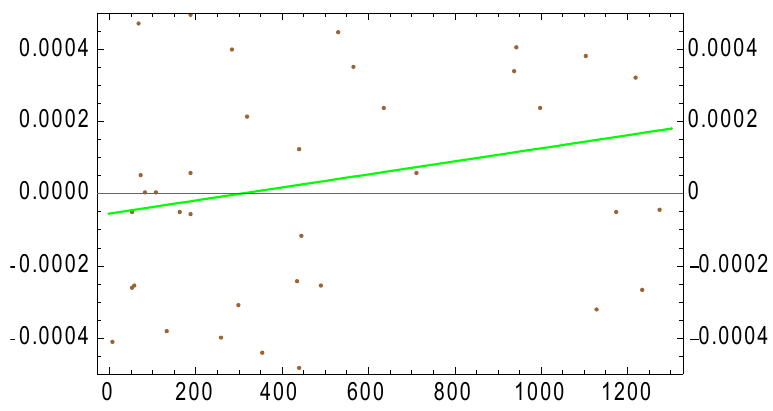
Figure 5. Difference in platinum and CZK price changes (detail).